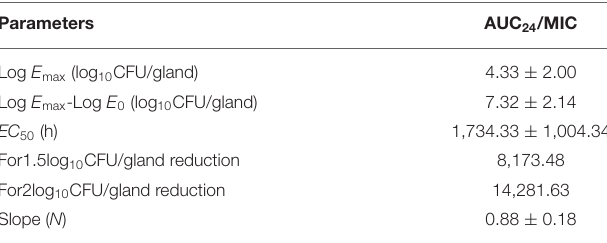
TABLE 5 | The important parameters in the AUC 24 /MIC using the inhibitory form E max sigmoid model after intramammary